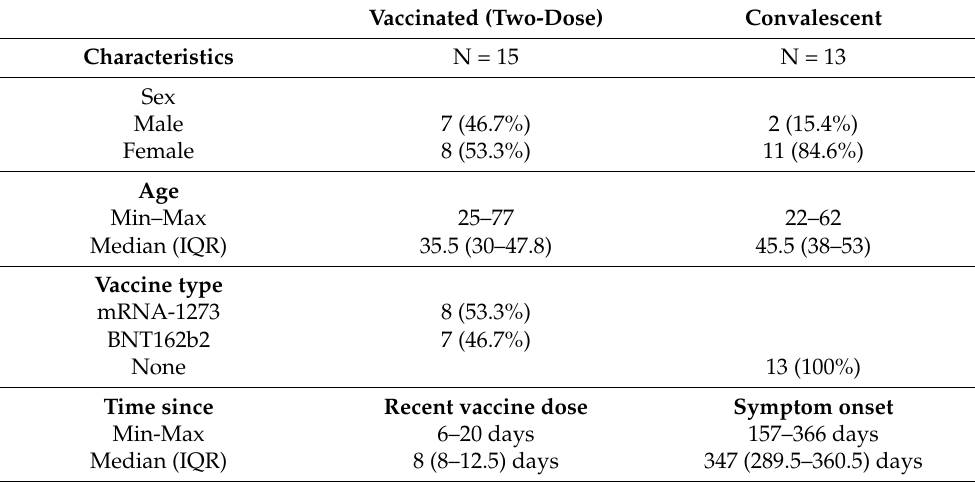
Table 1. Characteristics of pooled sera sets from vaccinated or convalescent serum. Vaccinated